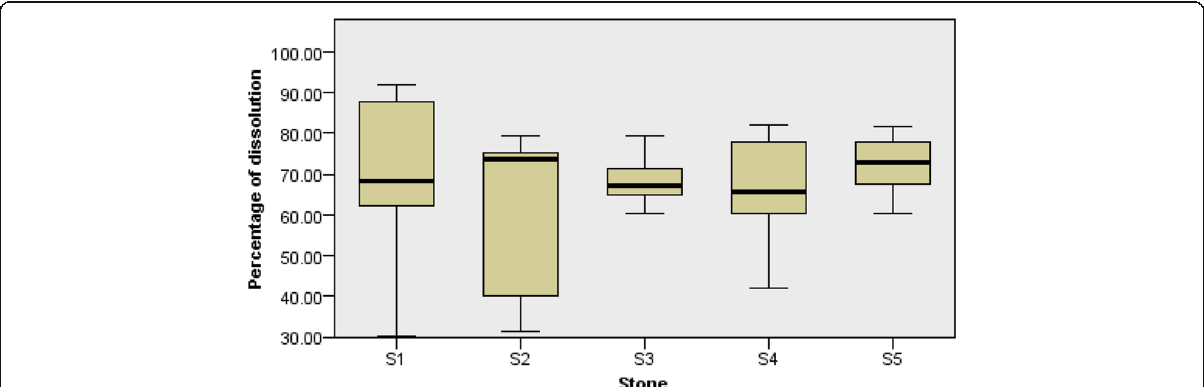
Fig. 5 Dissolution percentage of clinical stone (S1, S2, S3, S4, S5) by Arnebia euchroma , Gypsophila struthium and Alcea officinalis (Root) according to stone type